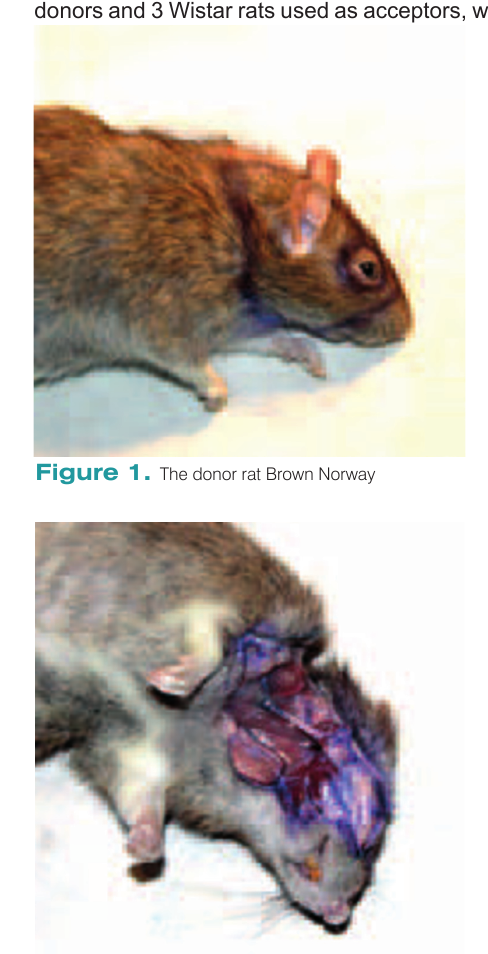
Figure 2. Anatomic dissection of the donor fl ap